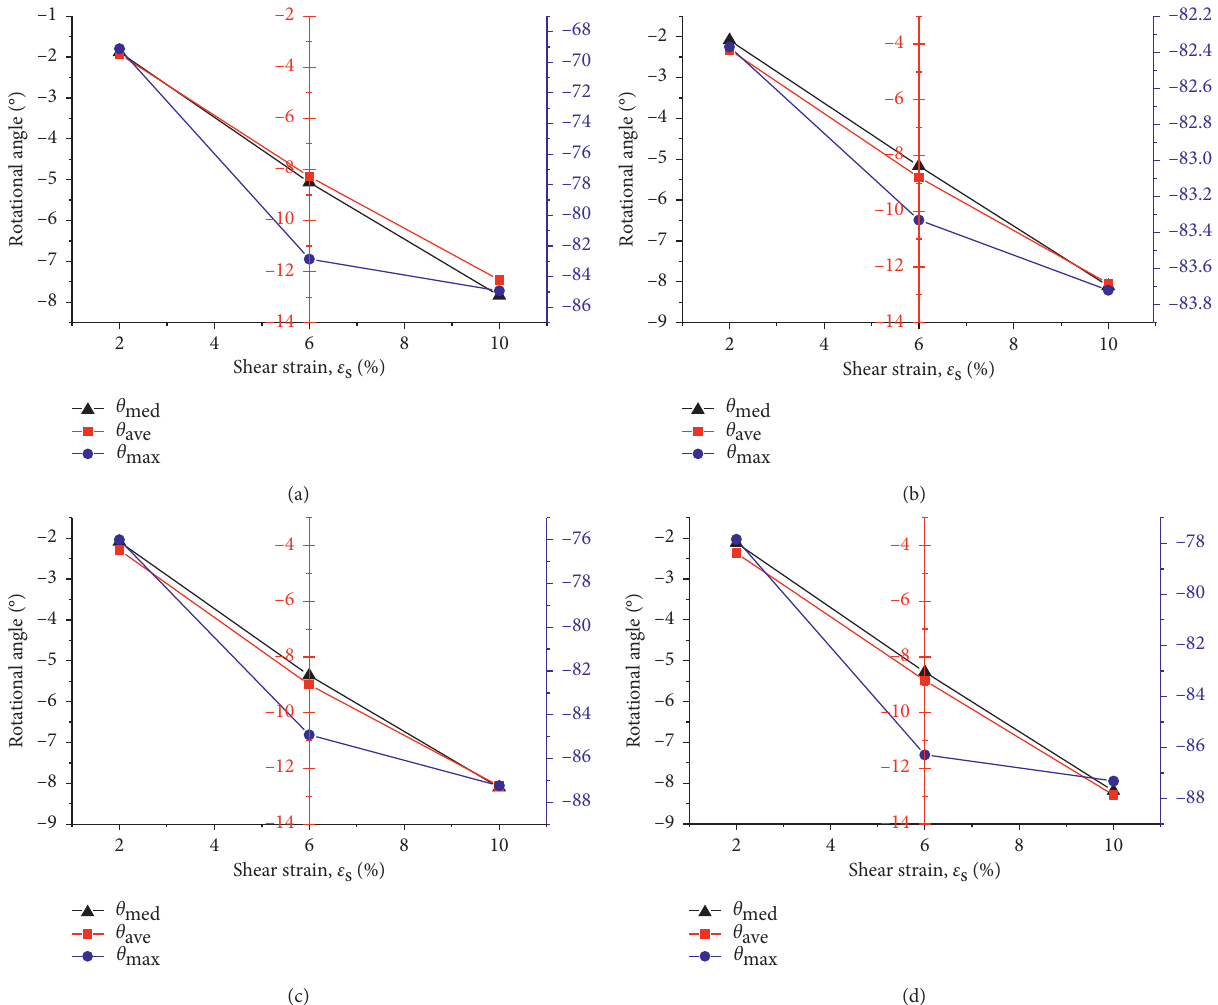
� 15 kPa; (b) σ � 35 kPa; n n